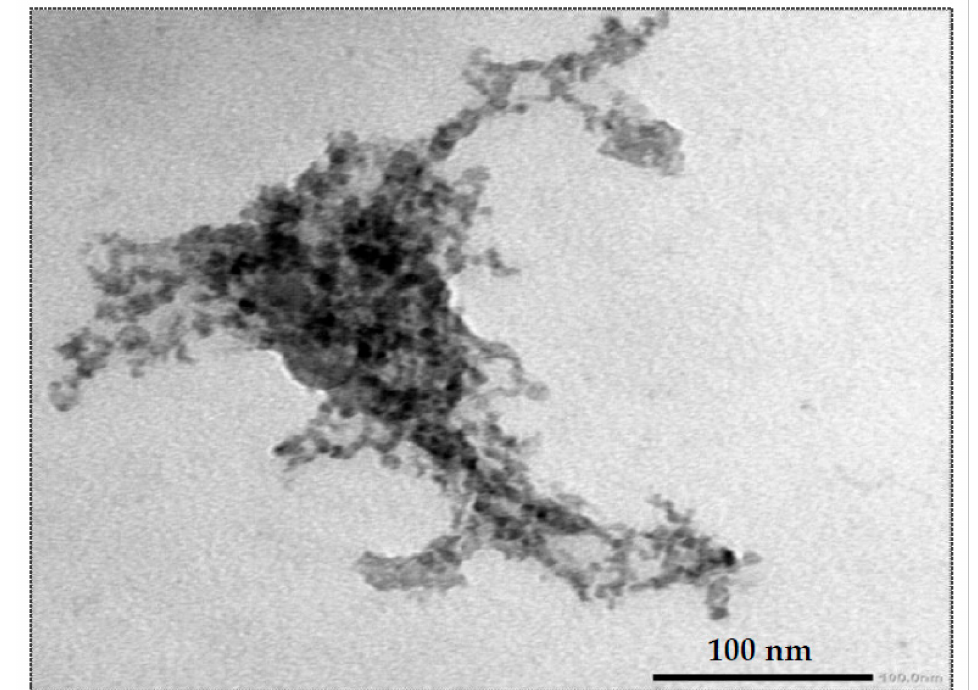
Figure 3. Transmission electron microscopy (TEM) image of silica nanoparticles (SiO 2 -NPs). Department, Faculty of Agriculture, Alexandria University, Egypt, during the growing season of 15th September 2020. According to the recommended doses of agricultural practices, nitrogen (N) as ammonium sulfate (20.5% N) at 2.5 g/pot, phosphorus (P) as calcium superphosphate (15.5% P 2 O 5 ) at 1.5 g/pot and potassium (K) as potassium sulfate (48% K 2 O) at 1 g/pot were added to each pot before transplanting. Also, further N doses (ammonium sulfate 20.5% N) were added at 30, 60, and 90 days after transplanting at 1.5 g/pot. The pots were irrigated on three days